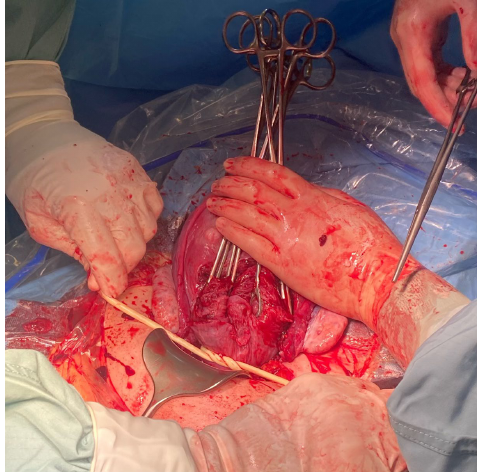
Figure 4. The assistant fixes a sterile Foley cathether “en bloc” around the cervix at the level of the uterosacral ligaments, about 3 – 4 cm below the level of the incision.